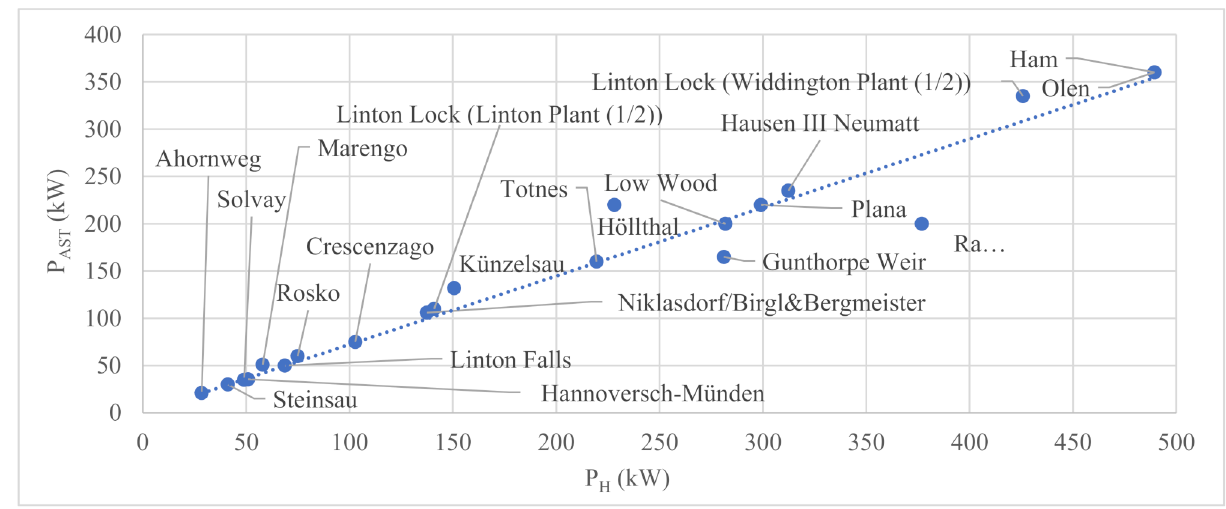
Figure 4. The theoretical available power vs. the power of installed screws published by manufacturers in current Archimedes screws hydropower plants represented in Table